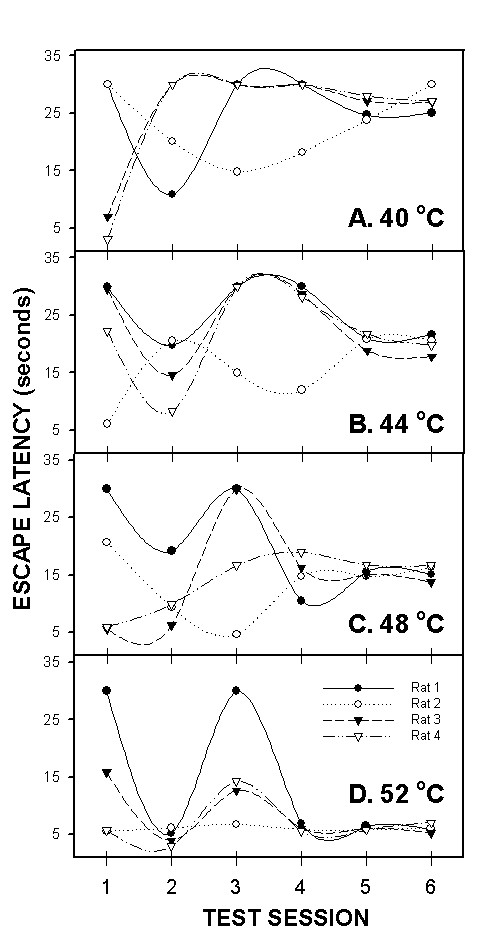
Algotrack individual responses of 4 sham rats for 4 temperatures 40 (A), 44 (B), 48 (C) and 52°C (D) plotted against test session. Illustrated are the first 6 sessions these animals were ever exposed to this paradigm. Each animal exhibits its own pattern of learning throughout the first few testing sessions, and then stabilizes to well-defined escape latencies for the different temperatures.